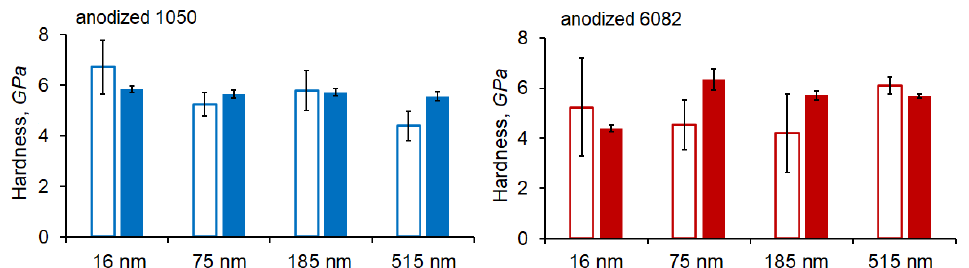
Figure 3. Influence of thickness of Ti layers on the indentation hardness of anodized 1050 and 6082 alloys. Depth-scan values for a surface segment (hollow bars: 100 – 200 nm) and substrate segment (solid bars: 2 –3 µm).